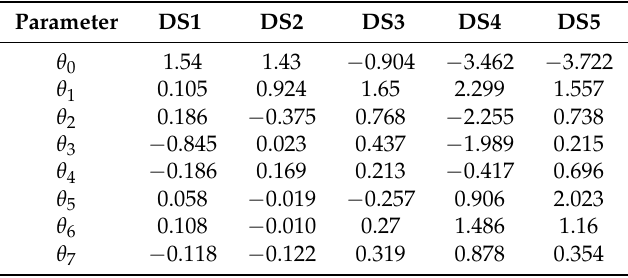
Table 1. Regression parameters of single-IM tsunami fragility neglecting flow